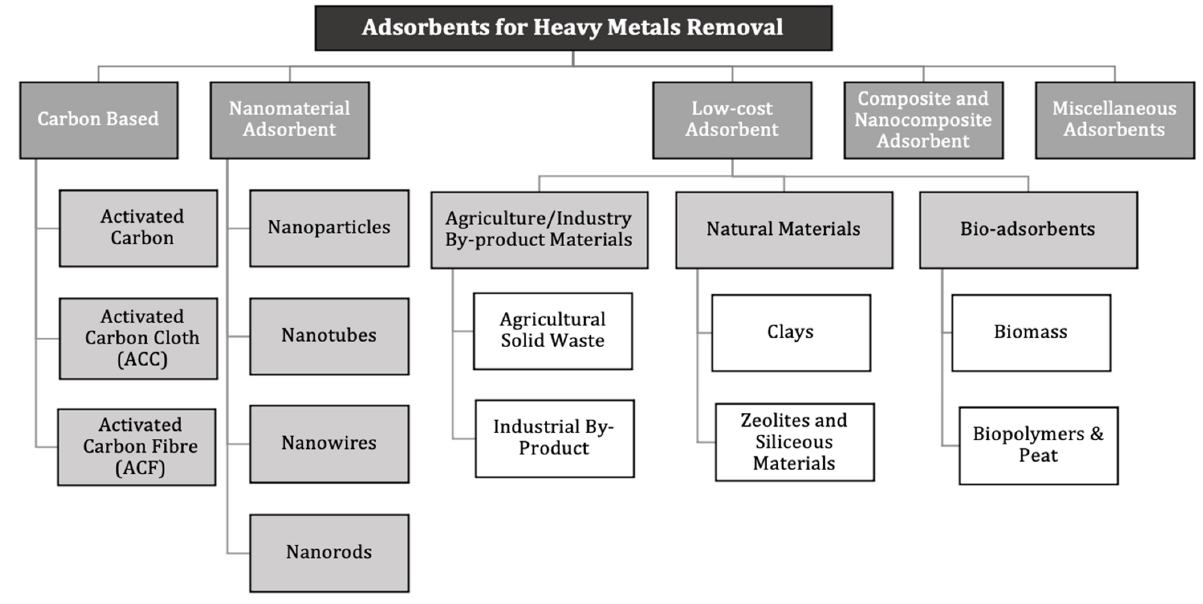
Figure 7. The classification of adsorbents used for remediation methods. Adopted from reference [34] (copyright reserved Elsevier, 2018). Table 9. Lists of adsorbent classification. Adopted from reference [34] (copyright reserved Elsevier,